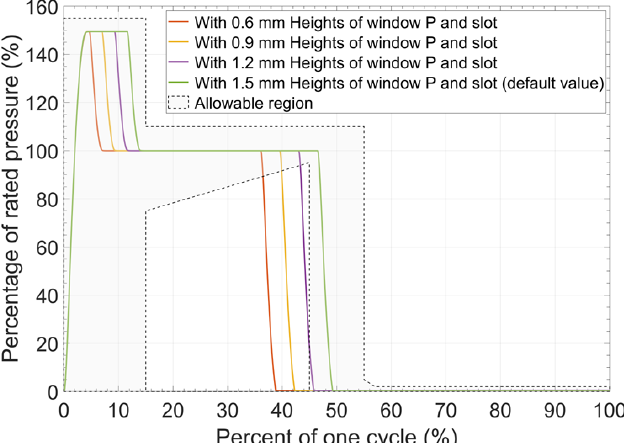
Figure 6. Effect of various heights of window P and slot.